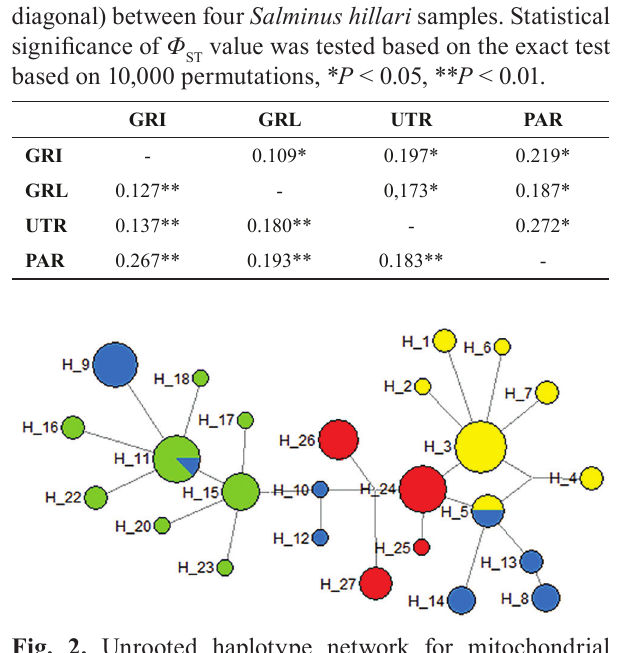
Fig. 2. Unrooted haplotype network for mitochondrial D-loop sequences of Salminus hilarii generated by NETWORK 4.1.1.2 based on the median joining algorithm. Sizes of the circled areas are proportional to the frequencies of the haplotypes at issue. Blue circles: rio Grande -Igarapava (GRI); Green circles: rio Grande -Lavras (GRL); Yellow circles: upper rio Tietê (UTR), and Red circles: rio Parapanema (PAR).